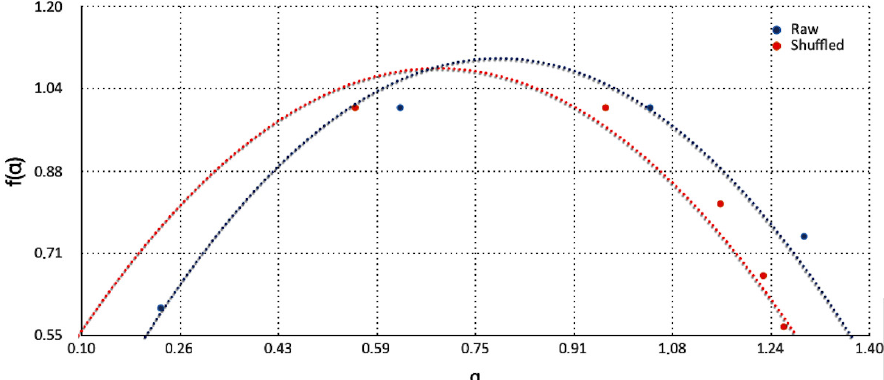
Figure 4. Multifractal plot of f ( α ) versus α for the THR monitoring station and date 7 July 2016 (case i/i = 11 of Table 2). Blue dots indicate the raw two-month series and the red dots the shuffled series. The dotted trendlines refer to fitted polynomial curves of order 2. For details, the reader should refer in-text.